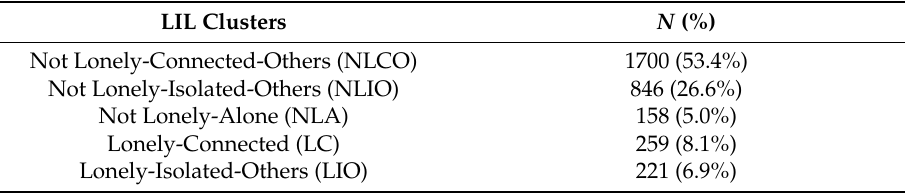
Table 3. LIL combination distribution of the community-based sample—five clusters